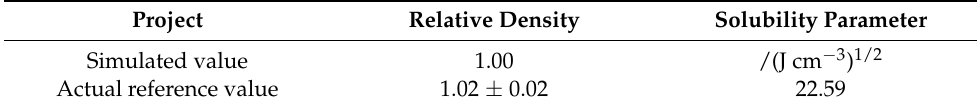
Table 3. Comparison of simulated and experimental results of the asphalt layer.